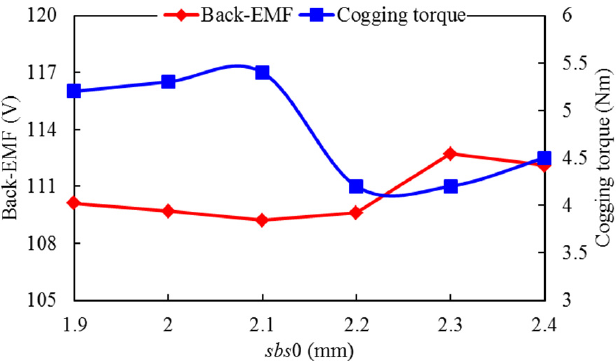
Figure 8. Variations of back-EMF and cogging torque with sbs0 .